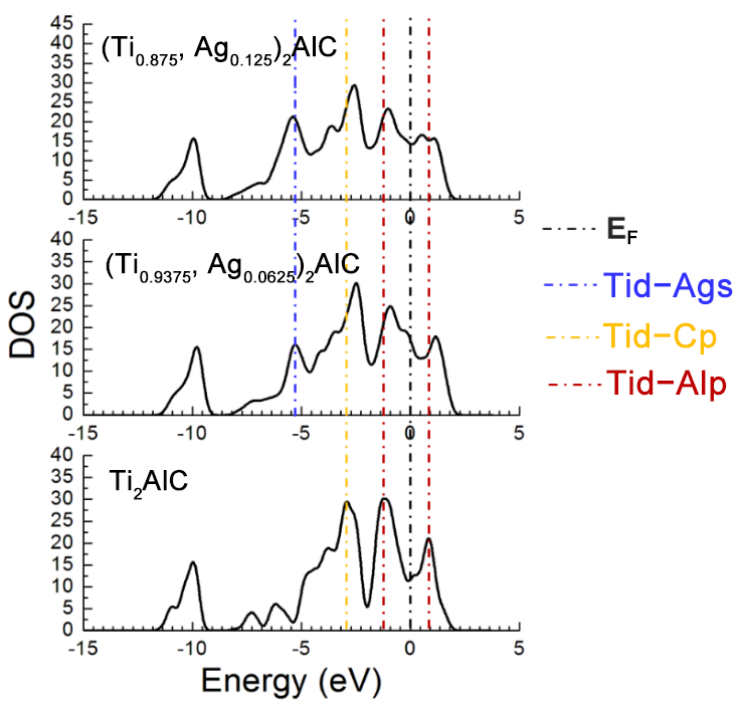
Figure 7. TDOS of the (Ti 1 − y ,Ag y ) 2 AlC supercells with different substitution ratios of Ag for Ti.